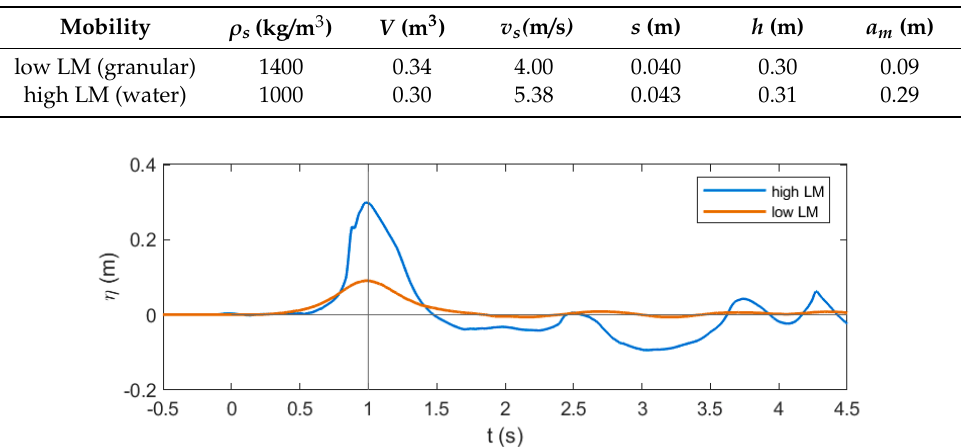
Table 1. Experimental conditions for examples of landslides with di ff erent mobility.